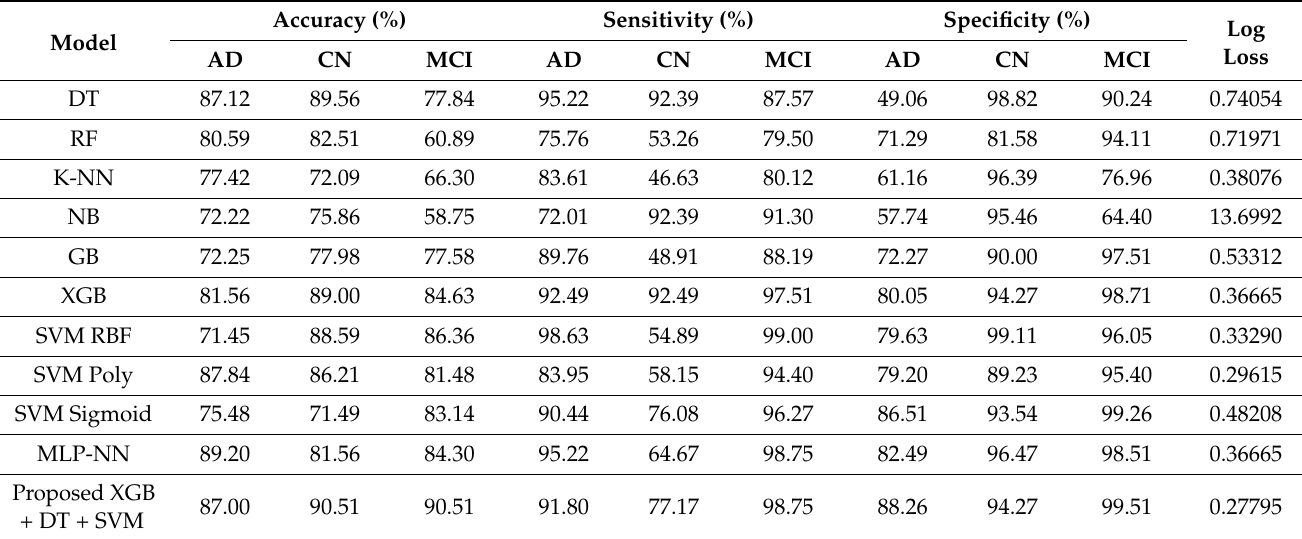
Table 5. Before hyperparameter tuning (parameter optimization) using GridSearch.